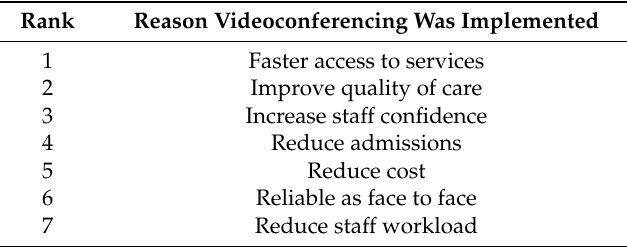
Table 7. Reasons for implementing videoconferencing (ranked most to least important).